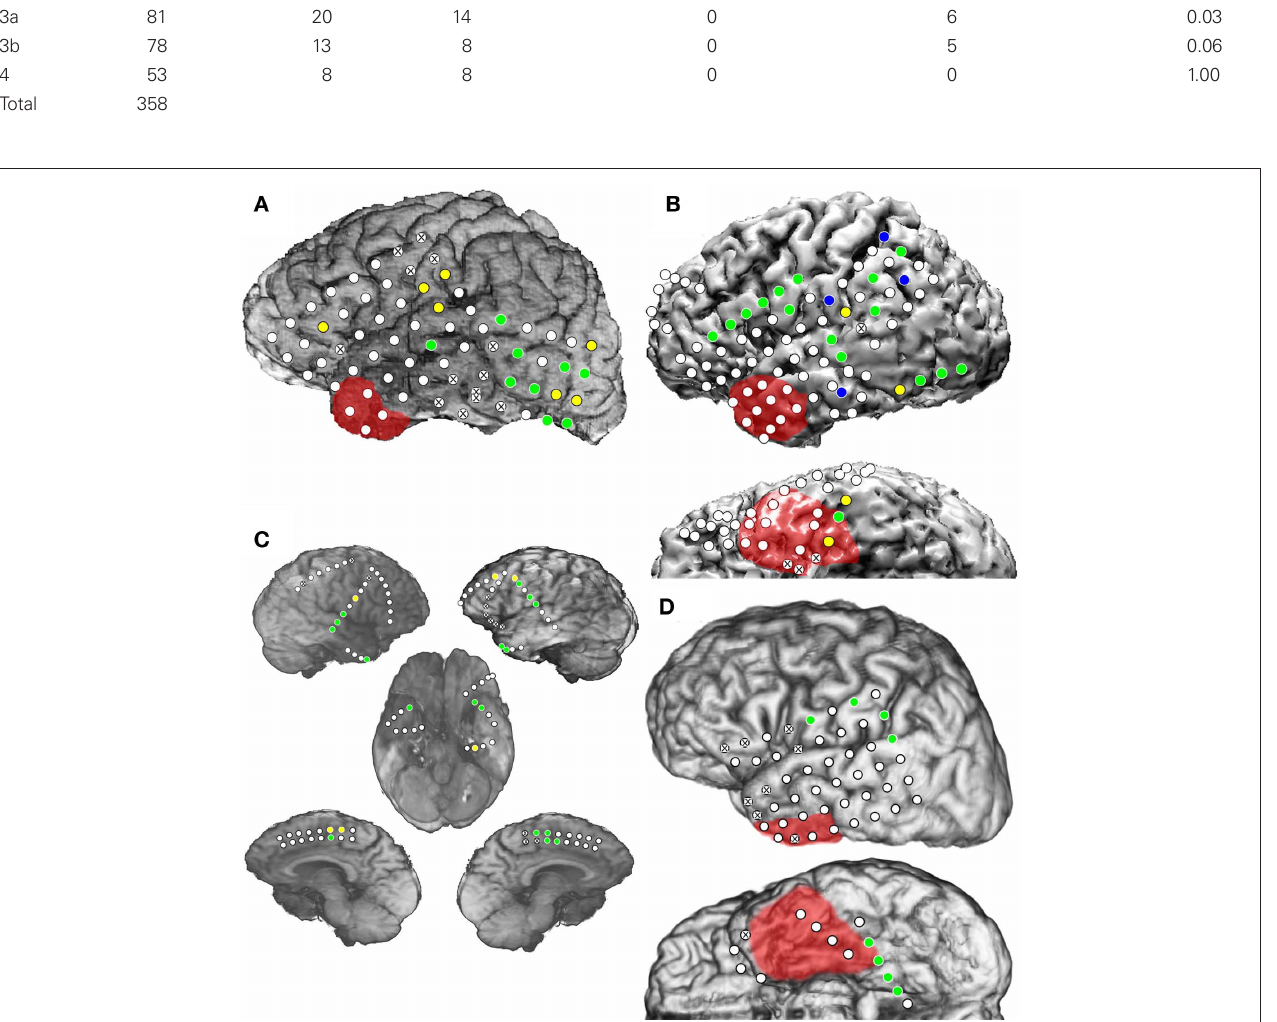
indicated with an “X”. Blue circles indicate HGA(+) electrodes during only L1 visual object naming. Yellow circles indicate HGA( + ) electrodes during only L2 visual object naming. Green circles indicate HGA( + ) electrodes during both L1 and L2 naming. As in Figure 1 , areas with red shading indicate resection